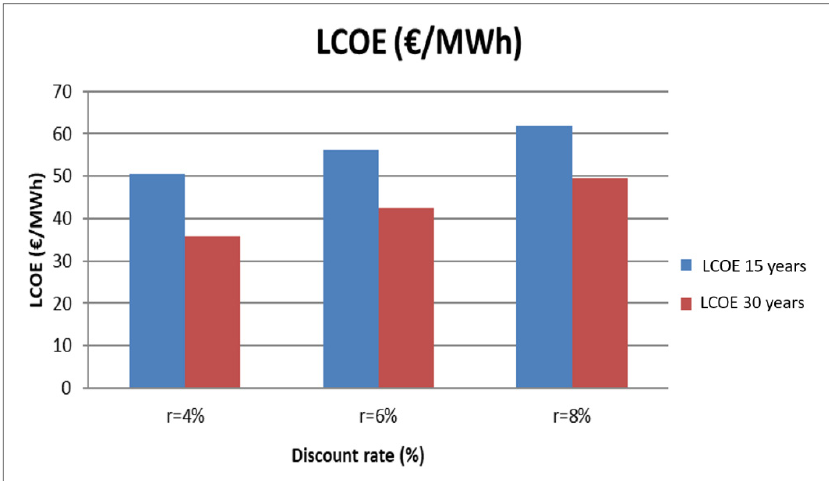
Figure 16. Variation of LCOE as a function of the discount rate and the years of useful life consid-